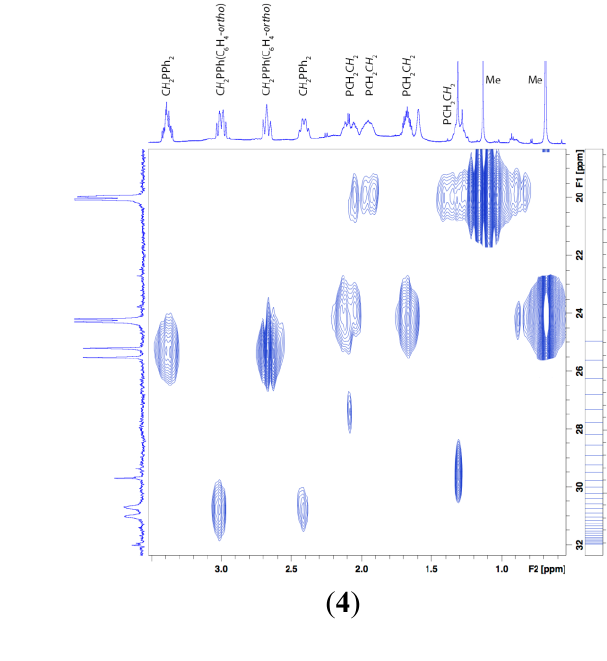
Figure 2. [ 1 H- 13 C] HSQC spectrum for 3 (on the left) and 4 (on the right) in CD solution at 25 °C showing the assignment of the proton